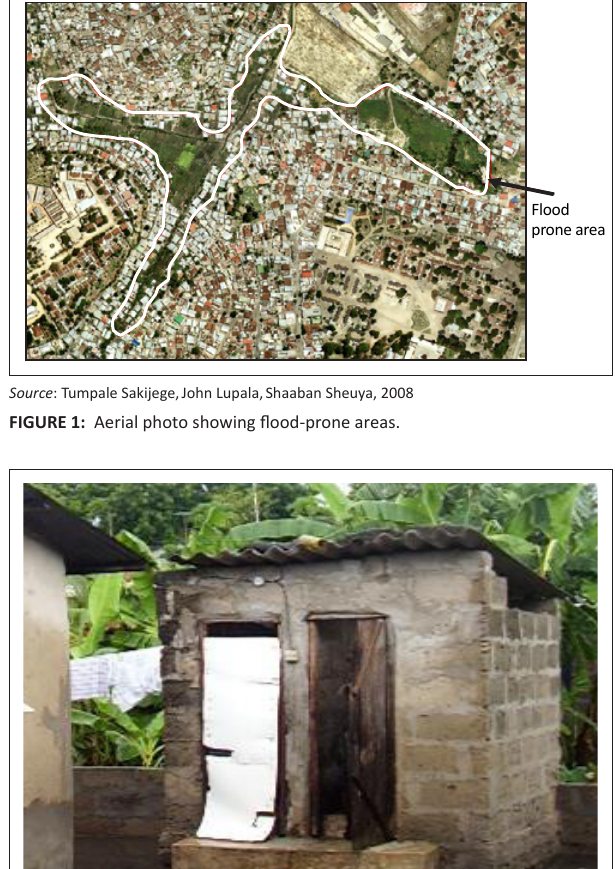
FIGURE 2: A pit latrine surrounded by stagnant water during rainfall season.